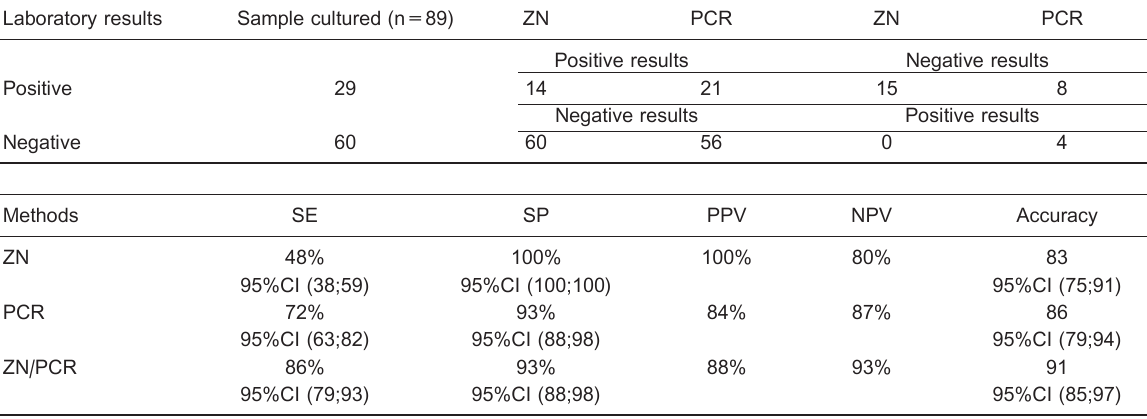
Table 1. Performance of the 3 methods (ZN, PCR and ZN/PCR). Laboratory